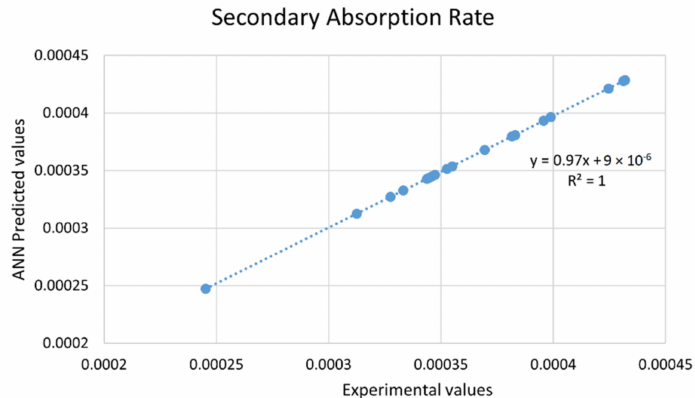
Figure 17. Secondary absorption rate—correlation between ANN and experimental values.